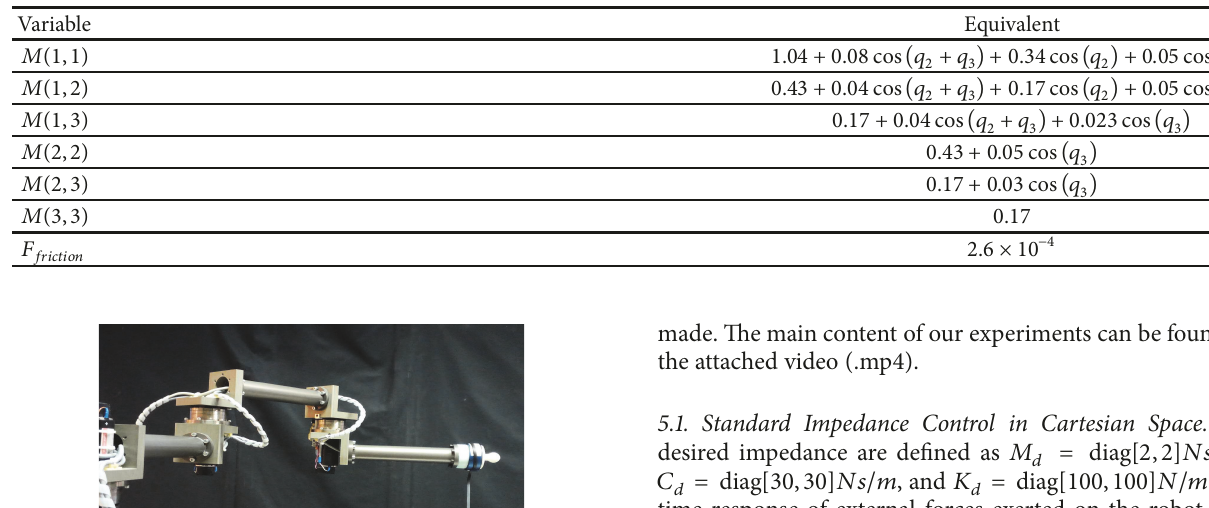
Table 2: Dynamic equations of the 3DOF Planar manipulator.